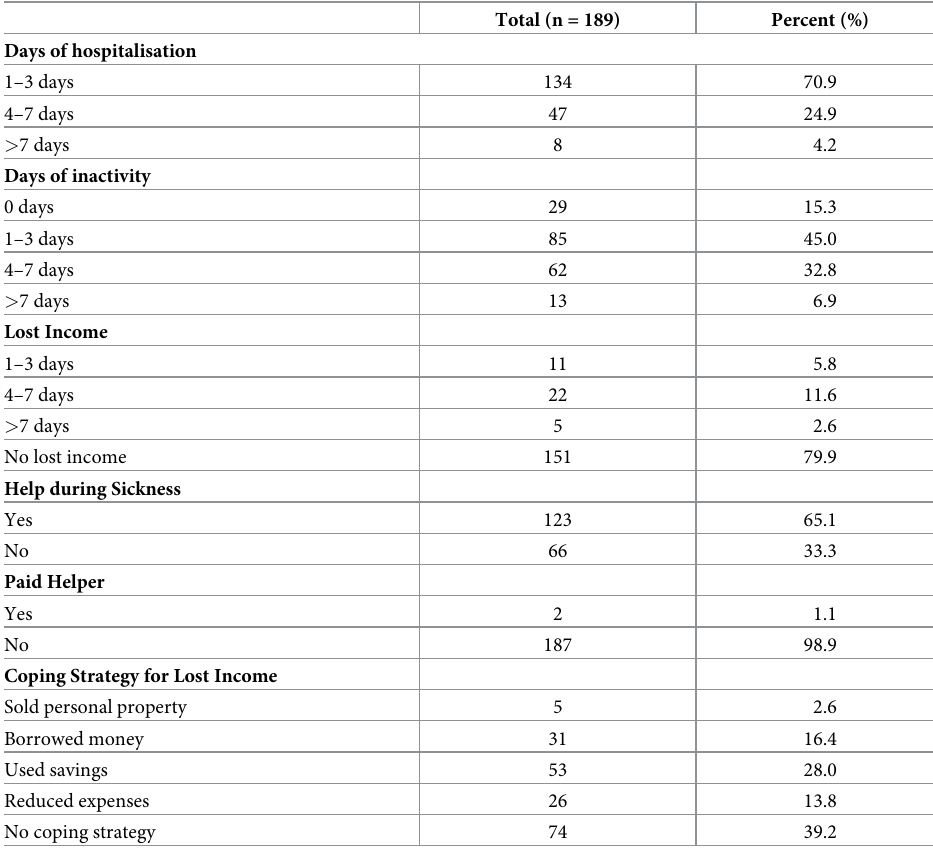
Table 5. Productivity losses during cholera outbreak.